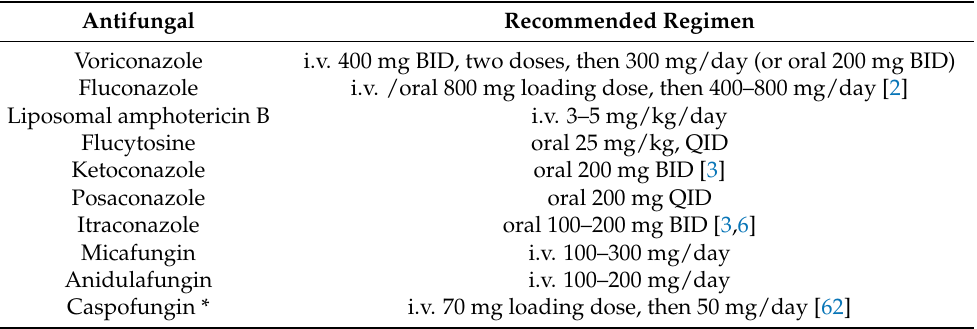
Table 4. Antifungal treatment regimens for